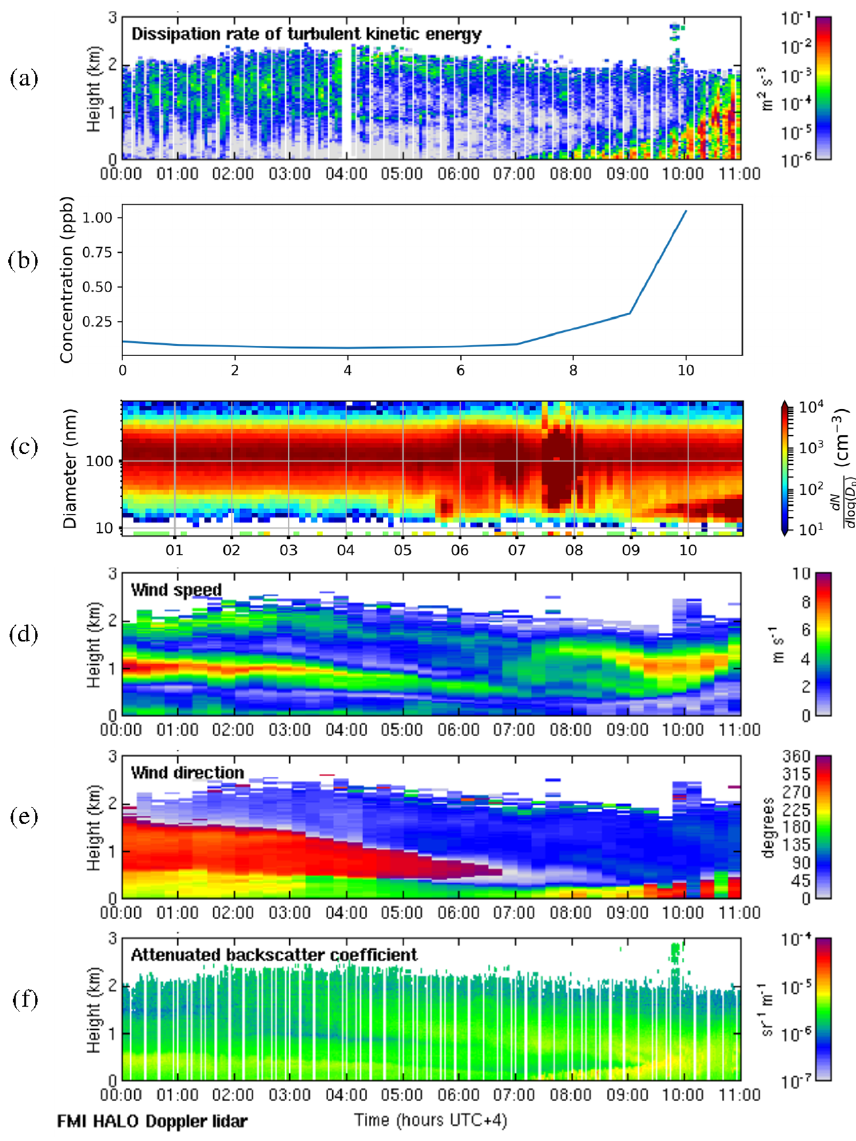
Figure 11. Deep-boundary-layer case with transport aloft on 19 May 2018. (a) Time–height plot of dissipation rate of turbulent kinetic energy, (cid:15) ; (b) SO 2 concentration (ppb) measured at the surface; (c) aerosol particle size distribution measured at the surface (the colour indicates the concentration d N/ dlog( d p ) in cm − 3 ); and time–height plots of (d) wind speed, (e) wind direction, and (f) attenuated backscatter coefficient. For all panels, the time axis is local time (hours UTC + 4). The measurements in panels ( a, d, e , and f ) were obtained from the HALO Doppler